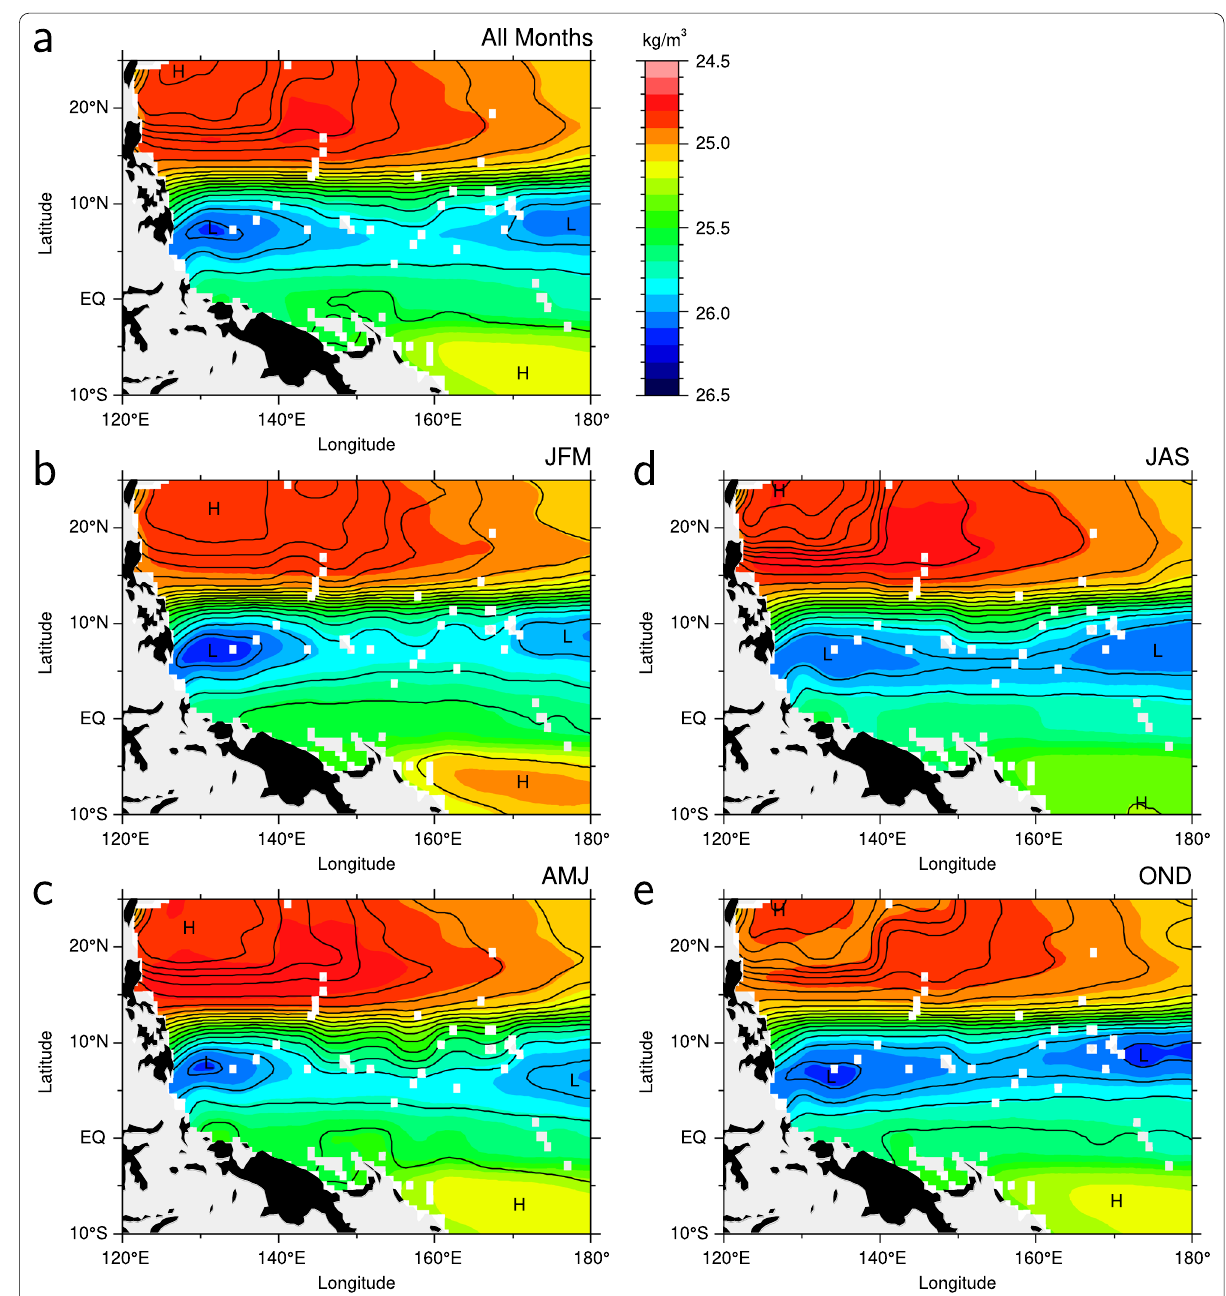
Fig. 5 Horizontal distributions of AGEM-derived potential density σ θ at a depth of 200 m ( kgm − 3 , color shading) and streamfunction χ 1000 ( Mkgs − 1 , contours) averaged in a all months, b January–March, c April–June, d July–September, and e October–December during 1993–2016. Contour intervals of streamfunction are 0.1 Mkgs − 1 . Letters H and L indicate maxima and minima of streamfunction,